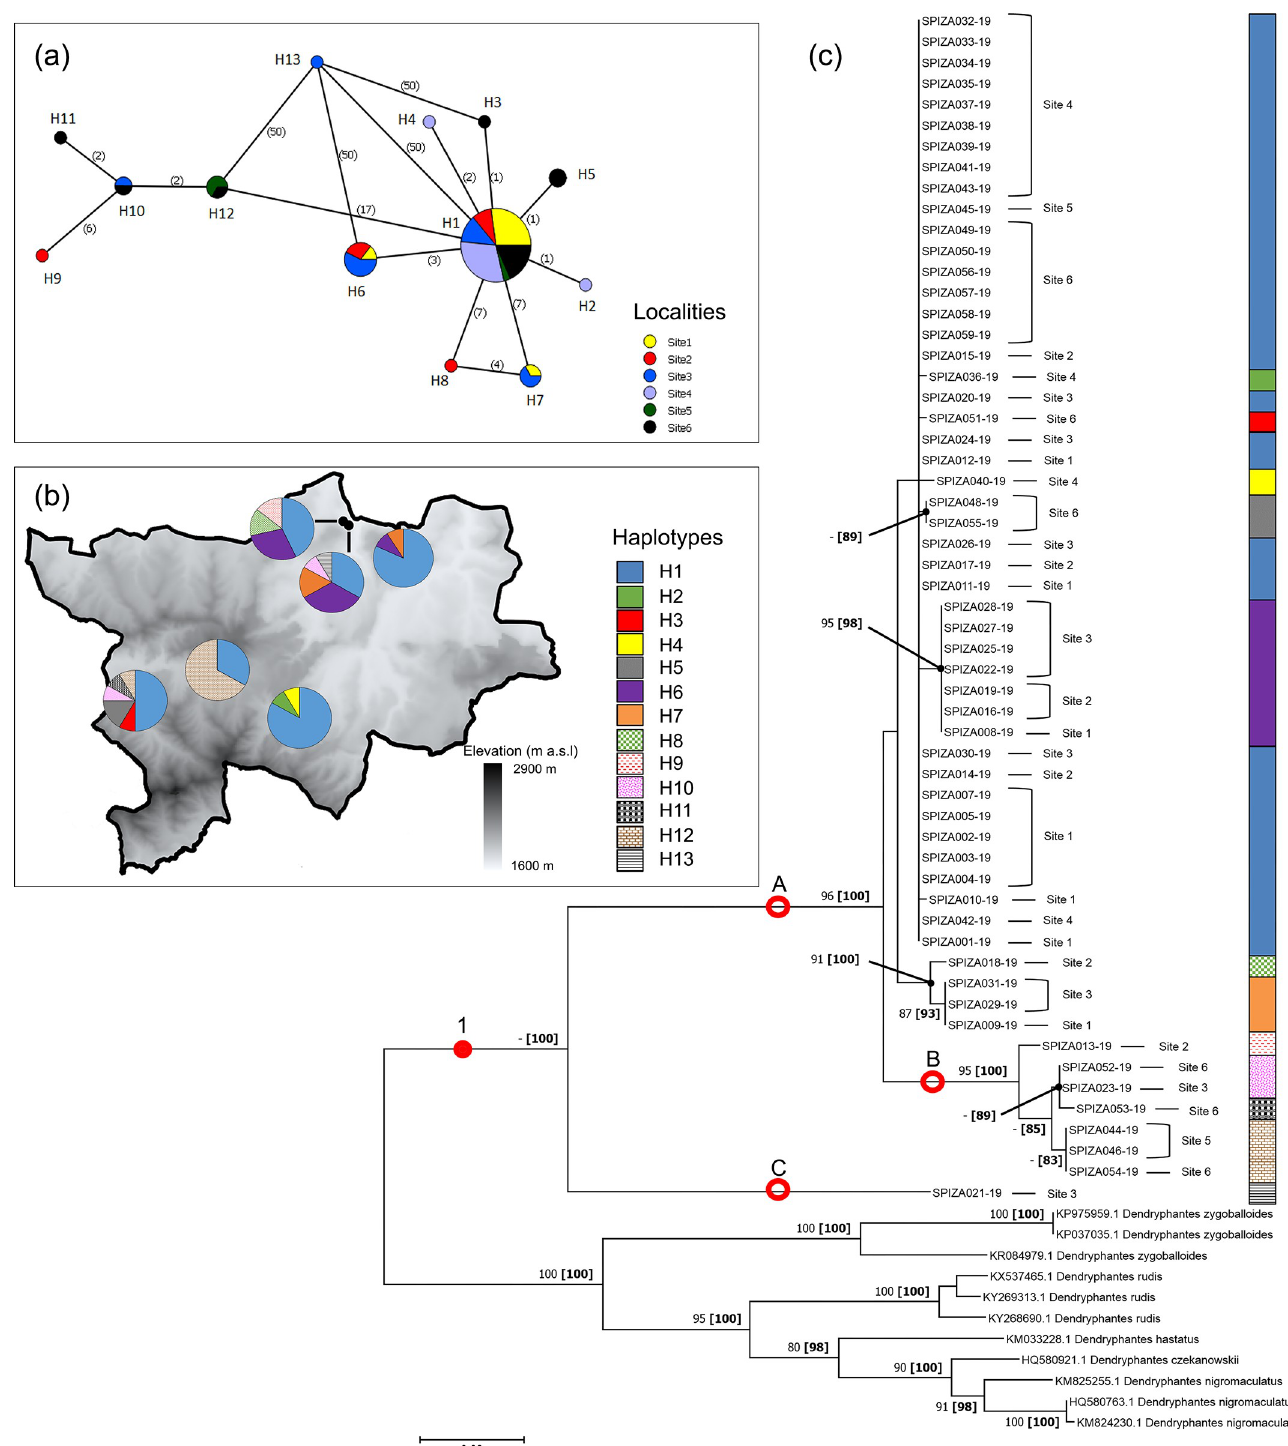
Fig 2. Haplotype networks and phylogram of Dendryphantes purcelli populations of the Golden Gate Highlands National Park, based on a portion of mt DNA COI gene. (a) Minimum Spanning Network (MSN) connecting sampled sequences through putative mutational steps according to geographical locality of populations. Circles represent defined haplotypes, while circle diameters are proportional to frequency. Numbers in parentheses correspond to mutational steps. (b) Distribution of defined haplotypes within sampled localities. (c) Phylogenetic tree based on Maximum Likelihood (ML) showing relationship of D . purcelli with five sister species. Red circles and dots represent well-supported and putative clades/groups, respectively. Localities and haplotypes of individuals corresponding to